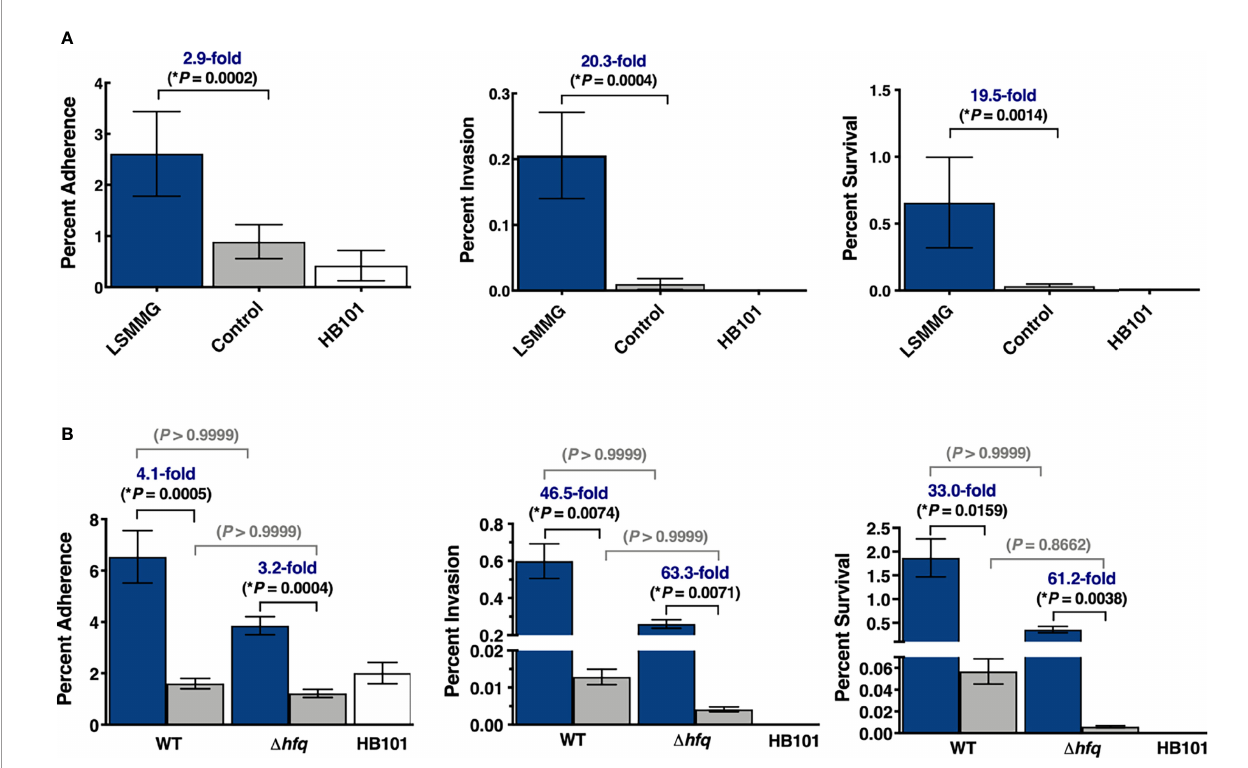
FIGURE 4 | Enhanced colonization of 3-D co-culture model with LSMMG-cultured S . Typhimurium. (A) Wild type S . Typhimurium was cultured under LSMMG (blue bars) or as re-oriented controls (gray bars). Error bars represent standard deviation from two biological replicates, each in technical triplicate (N = 6). (B) Wild type S . Typhimurium and an isogenic D hfq mutant were independently cultured under LSMMG (blue bars) or as sedimented controls (gray bars). Error bars represent standard deviation from two biological replicates, each in technical duplicate (N = 4). Multiplicity of infection was ~15-30. E. coli HB101 (white bars), was also included as a non-invasive control for all experiments. At each time point, serial dilutions of the host cell lysate were plated to assess colony forming units (CFU/mL). All data were normalized to the initial bacterial inoculum for each strain/condition. Data were assessed for normality using the Shapiro-Wilk test and were subsequently analyzed using Kruskal-Wallis non-parametric ANOVA with Dunn ’ s multiple comparisons. (*) indicates P < 0.05 and is only shown for the Salmonella